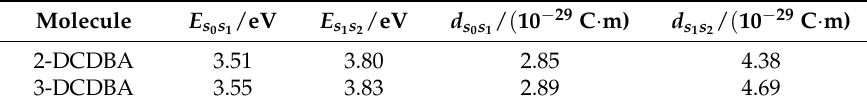
Table 1. Excitation energies and transition dipole moments of 2-DCDBA and